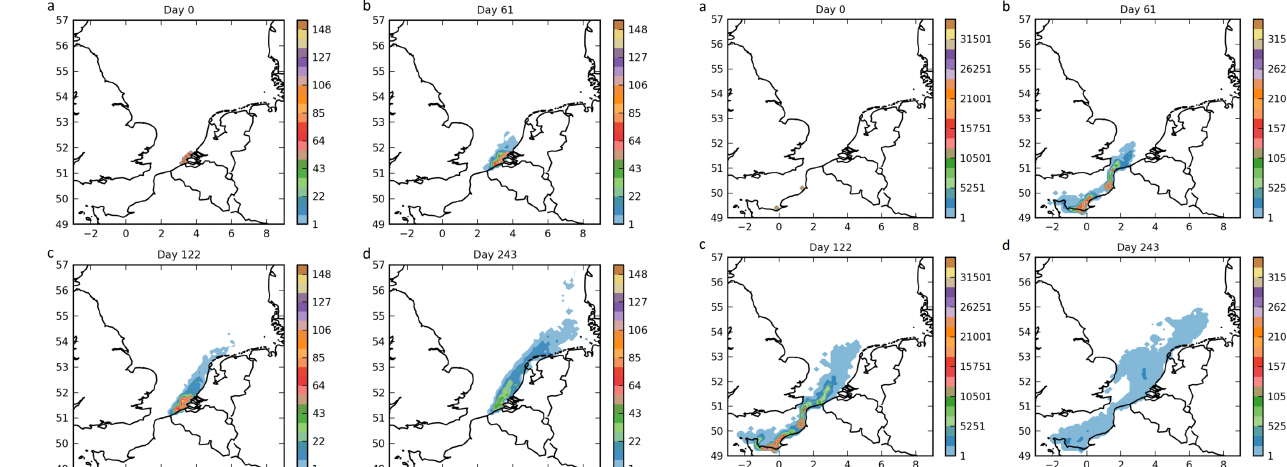
Figure 5. Density of particles on the model grid (number of par- ticles per grid cell). (a) on day 1 of the simulation (1 June 2008); (b) on day 61 (31 July 2008); (c) on day 121 (29 September 2008); (d) on day 240 (25 January 2009).